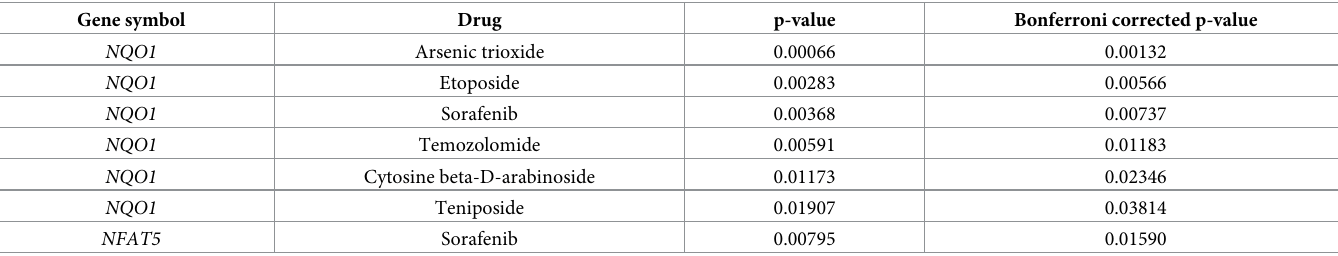
Table 3. Significant results from the multivariate linear regression of drug response on the baseline expression of NQO1 and NFAT5 genes. Gene symbol Drug p-value Bonferroni corrected p-value NQO1 Arsenic trioxide 0.00066 0.00132 NQO1 Etoposide 0.00283 0.00566 NQO1 Sorafenib 0.00368 0.00737 NQO1 Temozolomide 0.00591 0.01183 NQO1 Cytosine beta-D-arabinoside 0.01173 0.02346 NQO1 Teniposide 0.01907 0.03814 NFAT5 Sorafenib 0.00795 0.01590 Significant correlations between the multivariate drug response and the baseline expression of NQO1 and NFAT5 genes after a Bonferroni correction with a significance level of p < 0.05 applied per